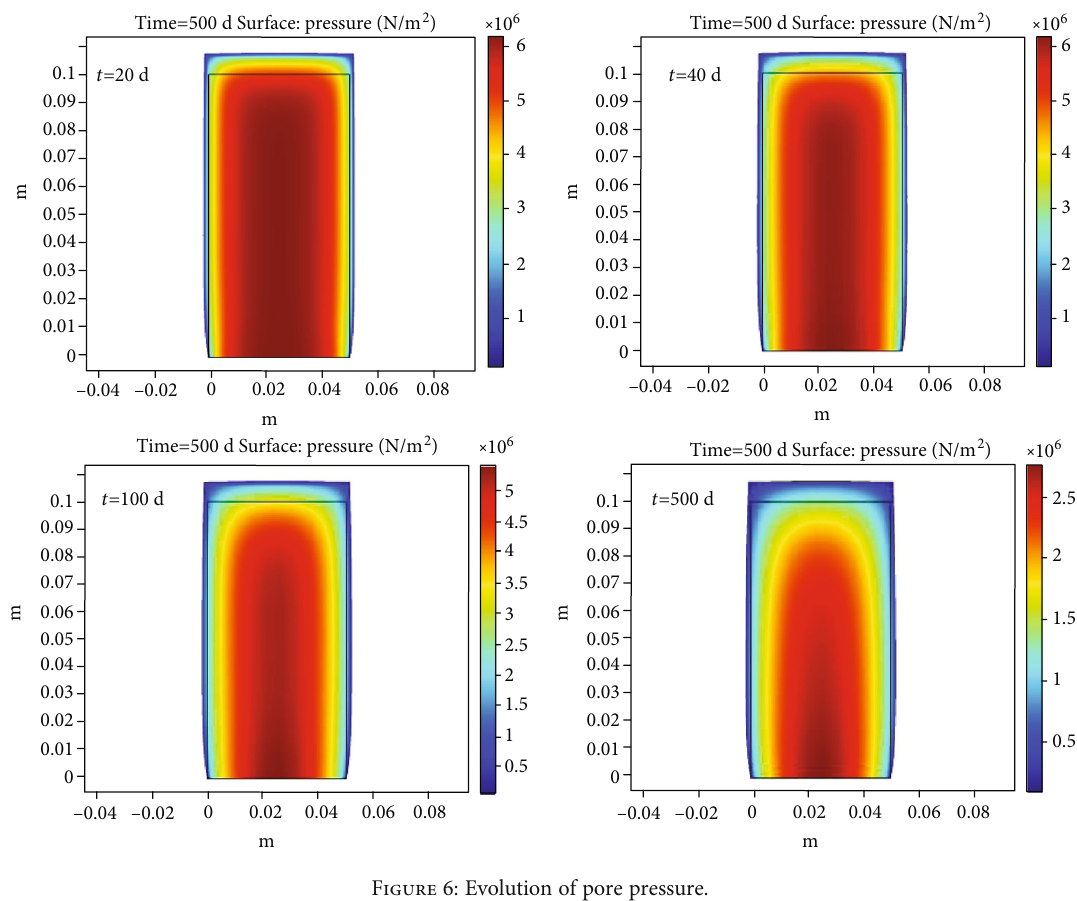
Figure 6: Evolution of pore pressure.